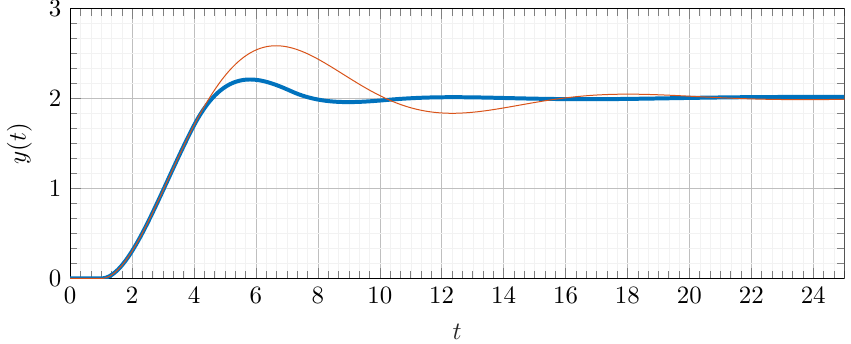
Figure 9. Closed-loop step response output y : (orange thin line) base PI controllers; (blue thick line) PI + CI controllers.